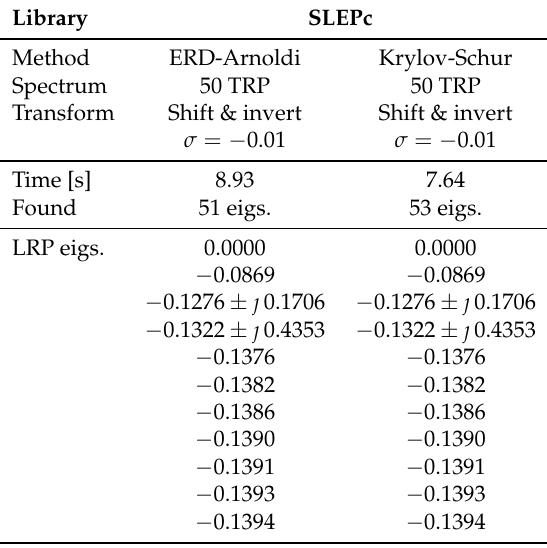
Table 10. AIITS: Krylov subspace methods, GEP.